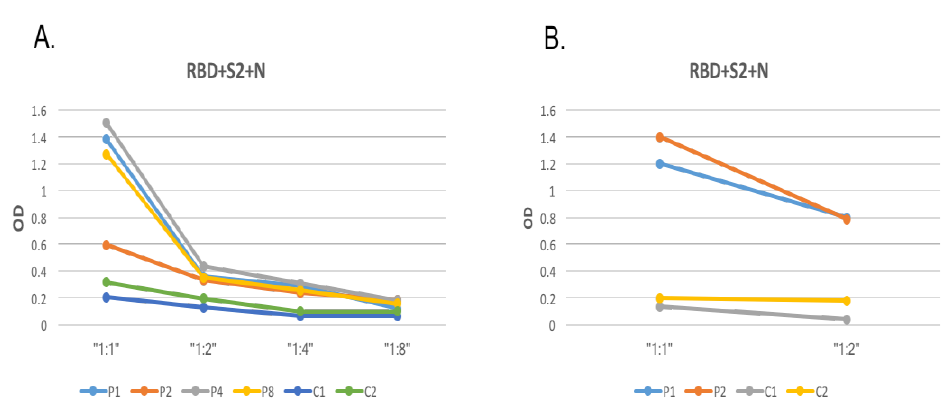
Figure 5. Optimization of SARS-CoV-2 protein coating concentration and serum dilution. ( A ) Four serial capture antigen dilutions (1:1, 1:2, 1:4, 1:8) were tested. ( B ) Two serial serum dilutions (1:100 and 1:200) were tested.